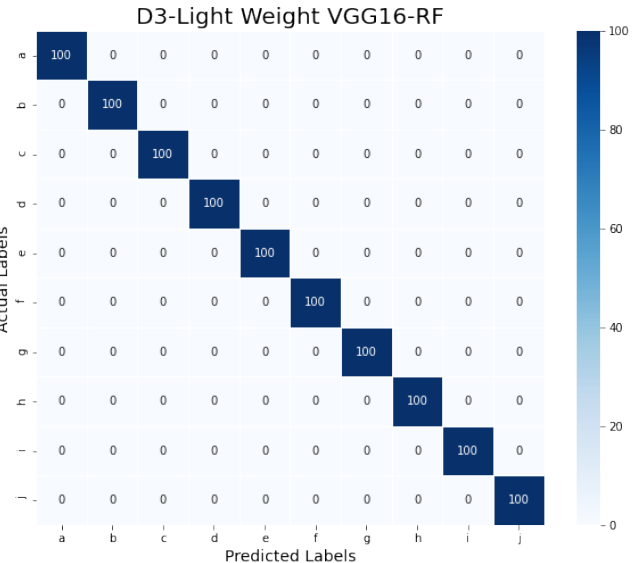
Figure 11. The confusion matrix of lightweight VGG16-RF on the NUS Hand Posture dataset.